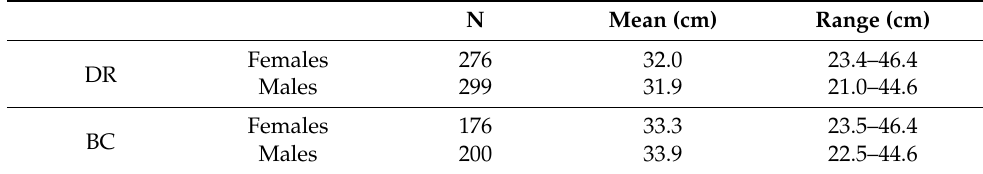
Table 2. Sample length description for the two data sets used for Trachurus picturatus growth modelling in Portuguese continental coast. DR—direct readings; BC—back-calculation; N—number of specimens; Mean—mean total length; Range—minimum and maximum total